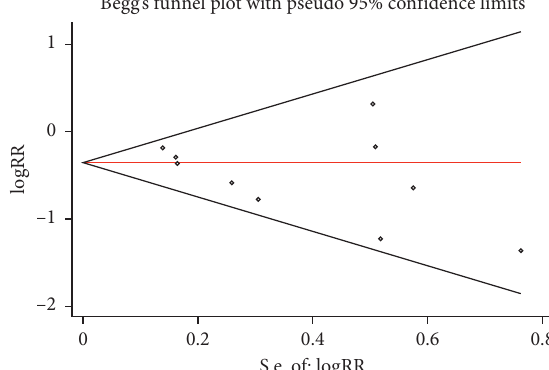
Figure 6: Comparison of PMI between the experimental group and the control group (Begg’s test). RR � risk ratio; PMI � periprocedural myocardial injury.